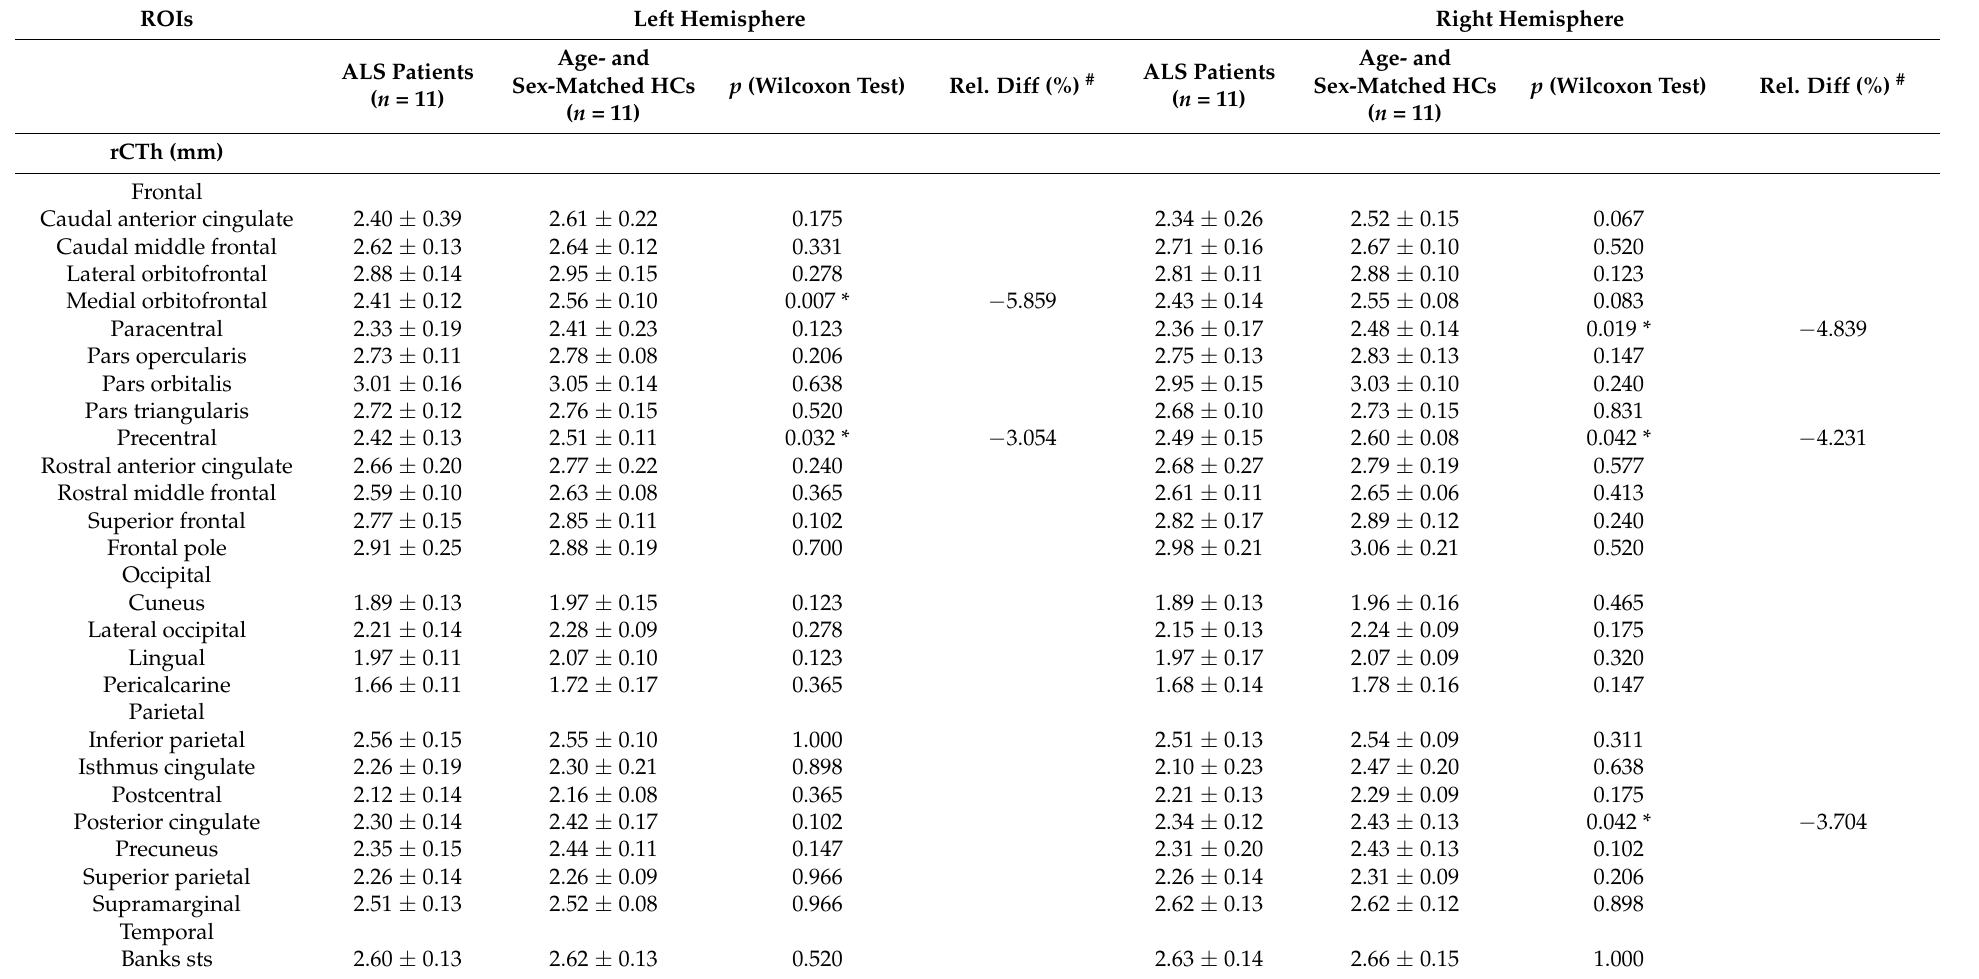
Table 4. Wilcoxon tests of the rCTh values as well as the SGMV values measured from ALS patients and age- and sex-matched health controls. ROIs Left